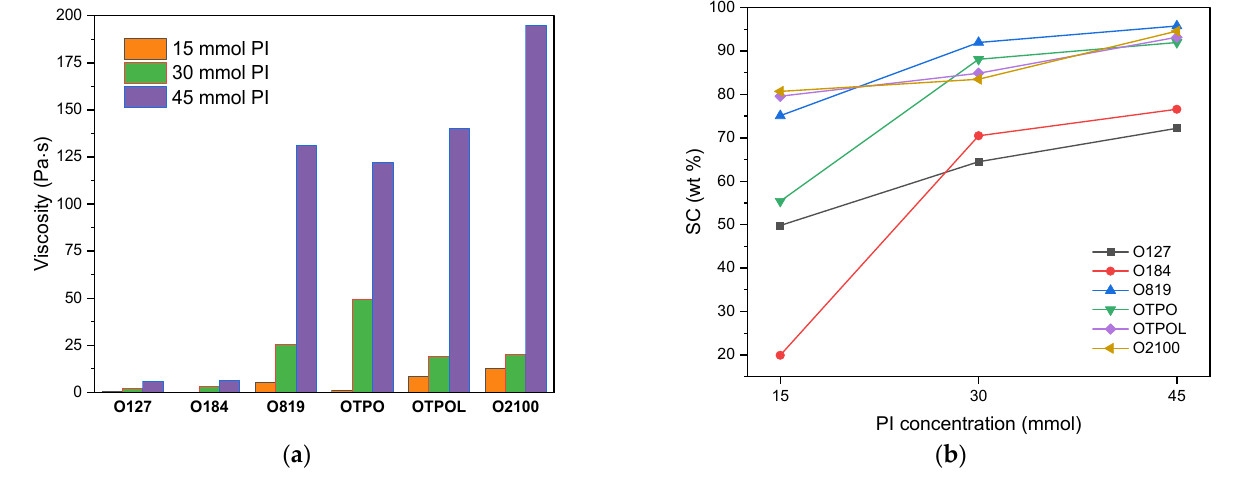
Figure 5. Viscosity ( a ) and solid content ( b ) of obtained BAA syrups. As can been seen, the viscosity and SC values increased with the amount of photoin- itiator used in the reaction. However, HP-based syrups exhibited significantly lower vis- cosity values (from 0.2 to 6.1 Pa·s) than APO-based products (from 5 to 185 Pa·s). The syrups with a viscosity below 3 Pa·s (BAA-127-15, BAA-127-30, and BAA-184-15) are not